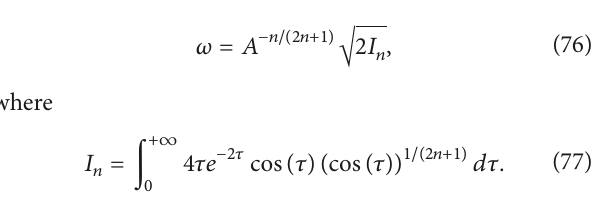
The periodic solution of (68)